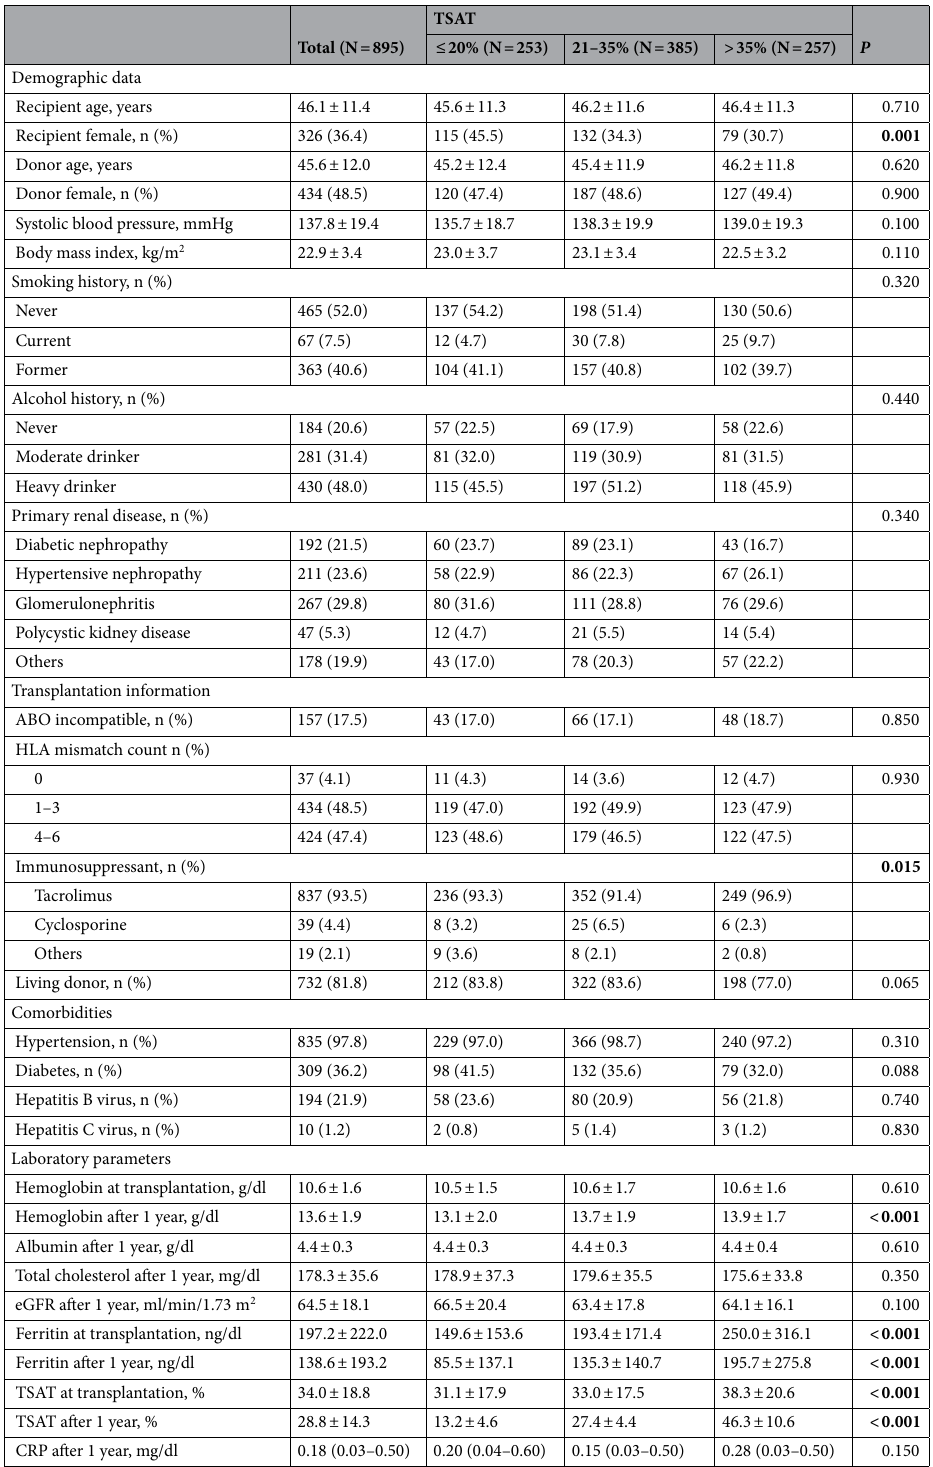
Table 1. Baseline characteristics of patients with respect to the TSAT. Data are presented as the mean ± standard deviation, number (percentage), or median (interquartile range). Significant values are in bold. SD standard deviation, HLA Human leukocyte antigen, eGFR estimated glomerular filtration rate, TSAT transferrin saturation, CRP c-reactive